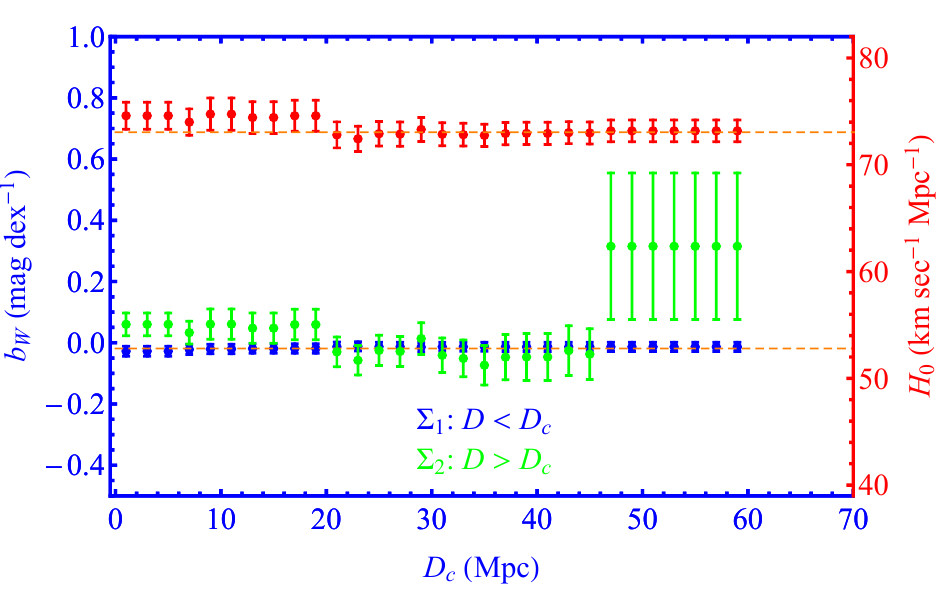
Figure 9. Same as Figure 8 in an analysis generalization, where the parameter b W is allowed to have a transition at a distance D c . Notice the sharp increase in the difference between best-fit parameters − b < | for D c > 47 Mpc. high of D and low D bin | b > W W